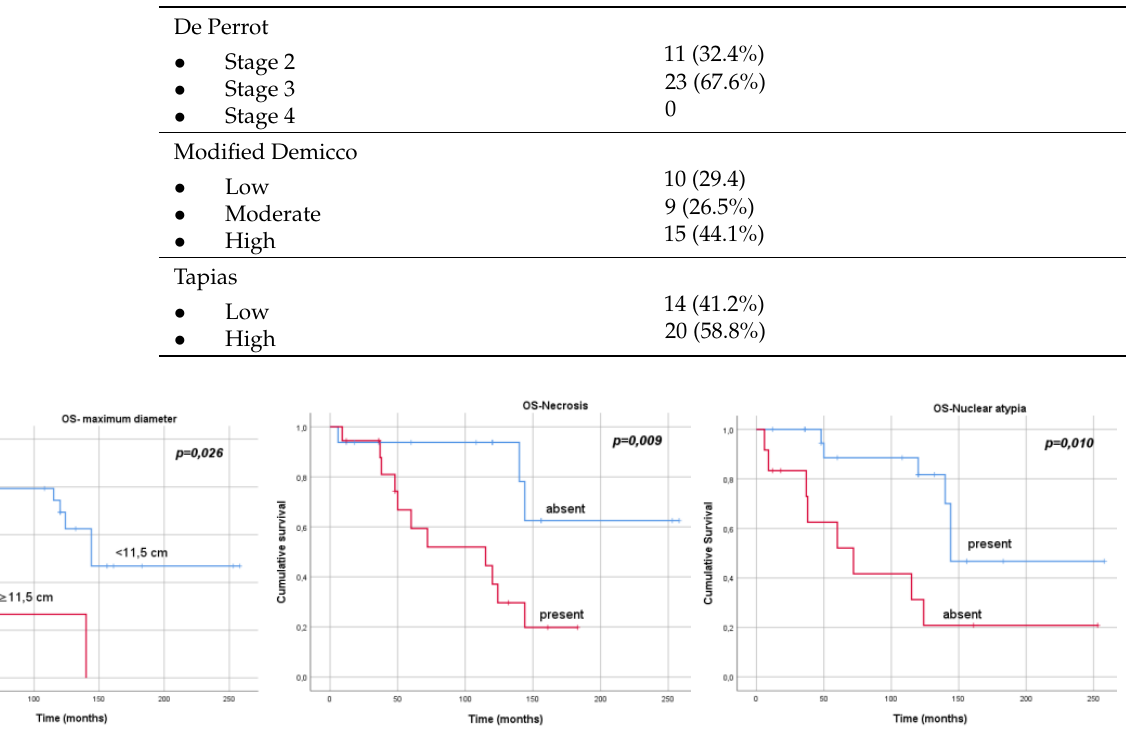
Figure 2. Kaplan – Meier curves, overall survival and tumour s’ characteristics. Figure 2. Kaplan–Meier curves, overall survival and tumours’ characteristics. Table 5. Univariate and multivariate analyses for